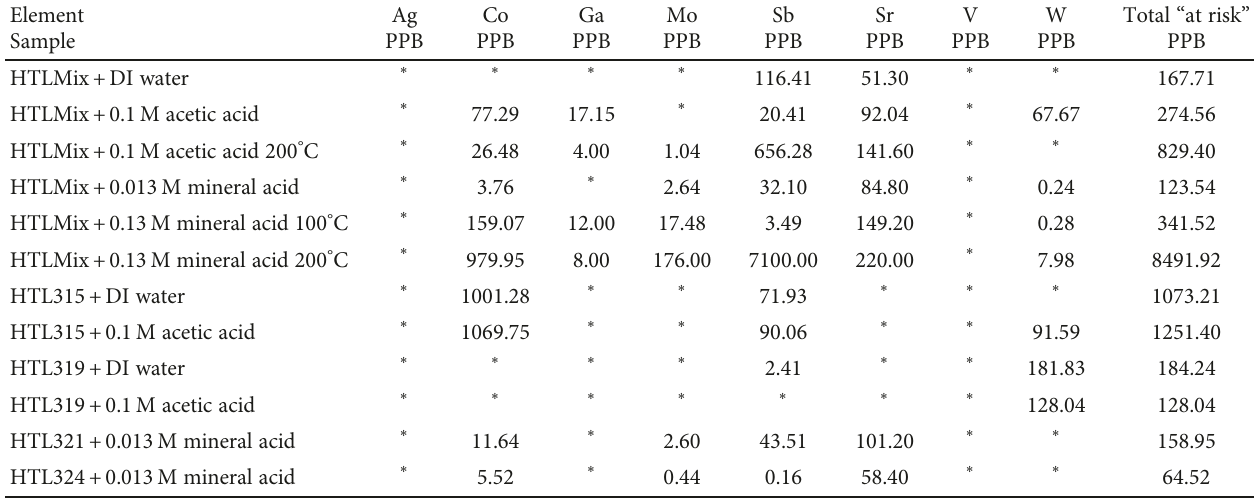
Table 4: Concentration of the “ at risk ” elements in each leachate from the batch reaction.